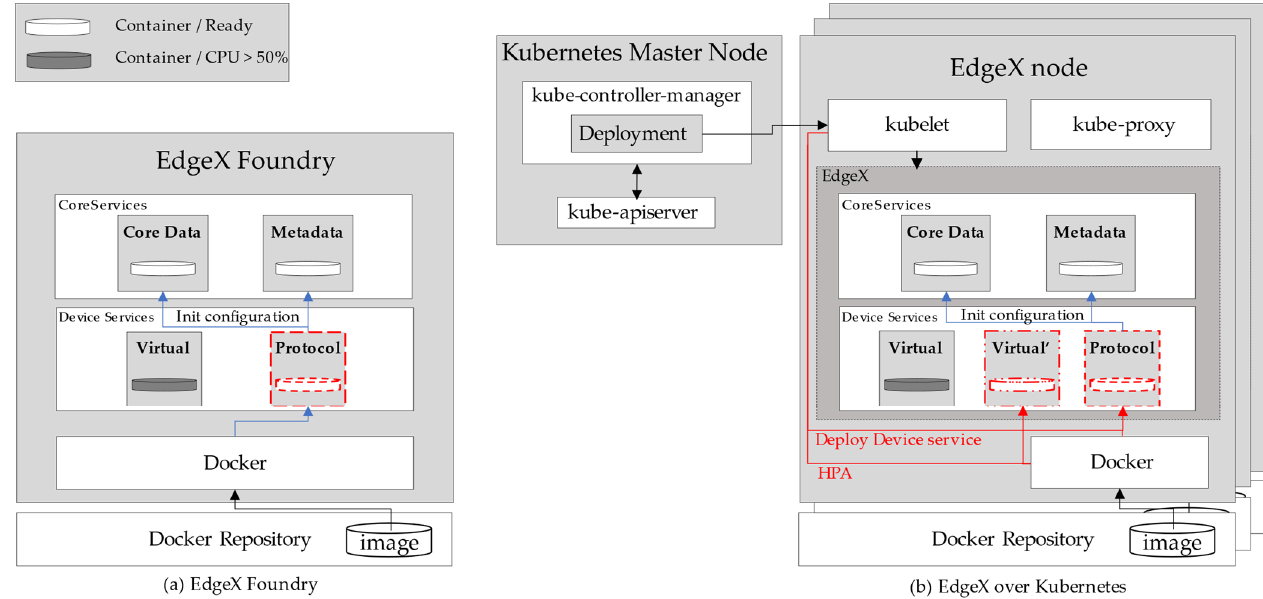
Figure 1. Schematic illustrations of the concepts of ( a ) EdgeX Foundry and ( b ) EdgeX over